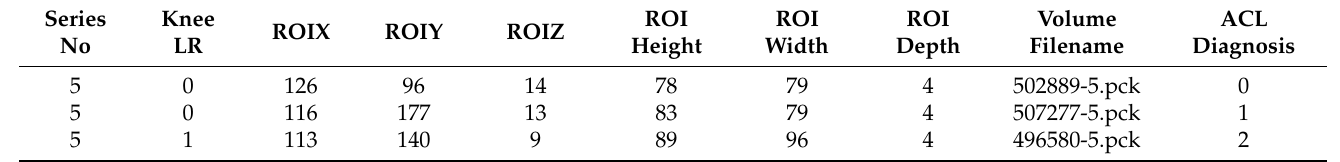
Table 2. The samples of metadata of 9 features and 1 class label of ACL